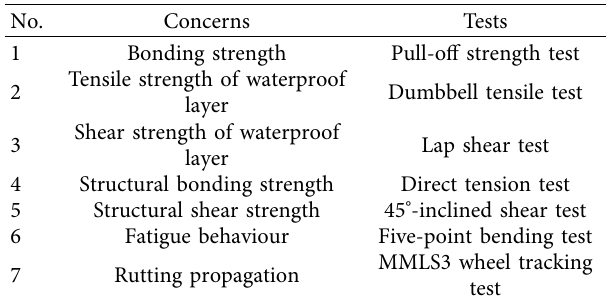
Table 2: Laboratory tests